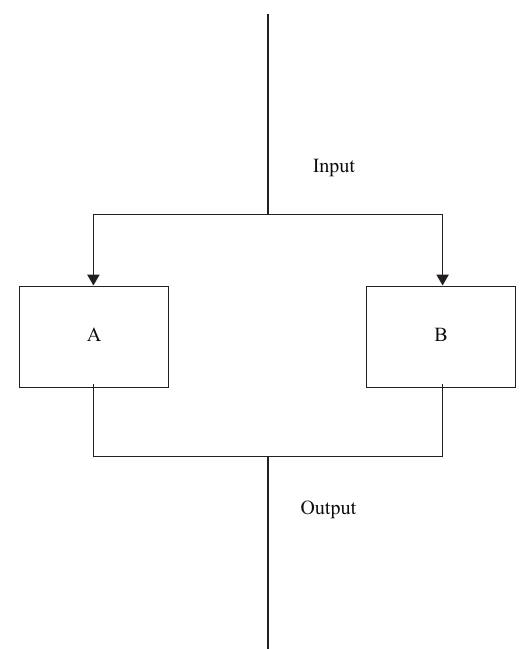
Figure 1: Schematic diagram of parallel combination